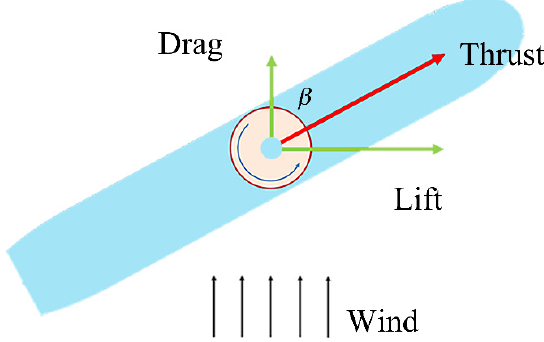
Figure 14. Mechanism of wind-assisted rotors.